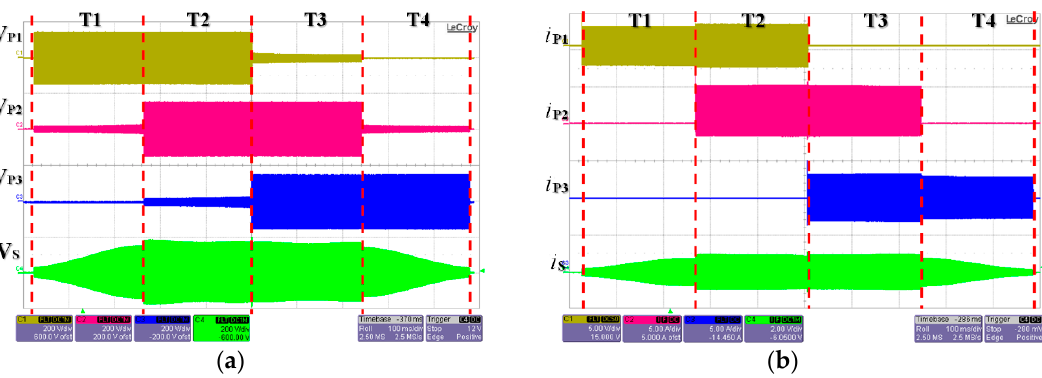
Figure 10. Waveforms of the P topology IPT system operated at mode 2H (air gap: 10 mm; time: 100 ms/div.; voltage: 200 v/div.; current i p1 , i p2 , and i p3 : 5 A/div.; current i s : 2 A/div.) ( a ) Voltages; ( b ) Currents.